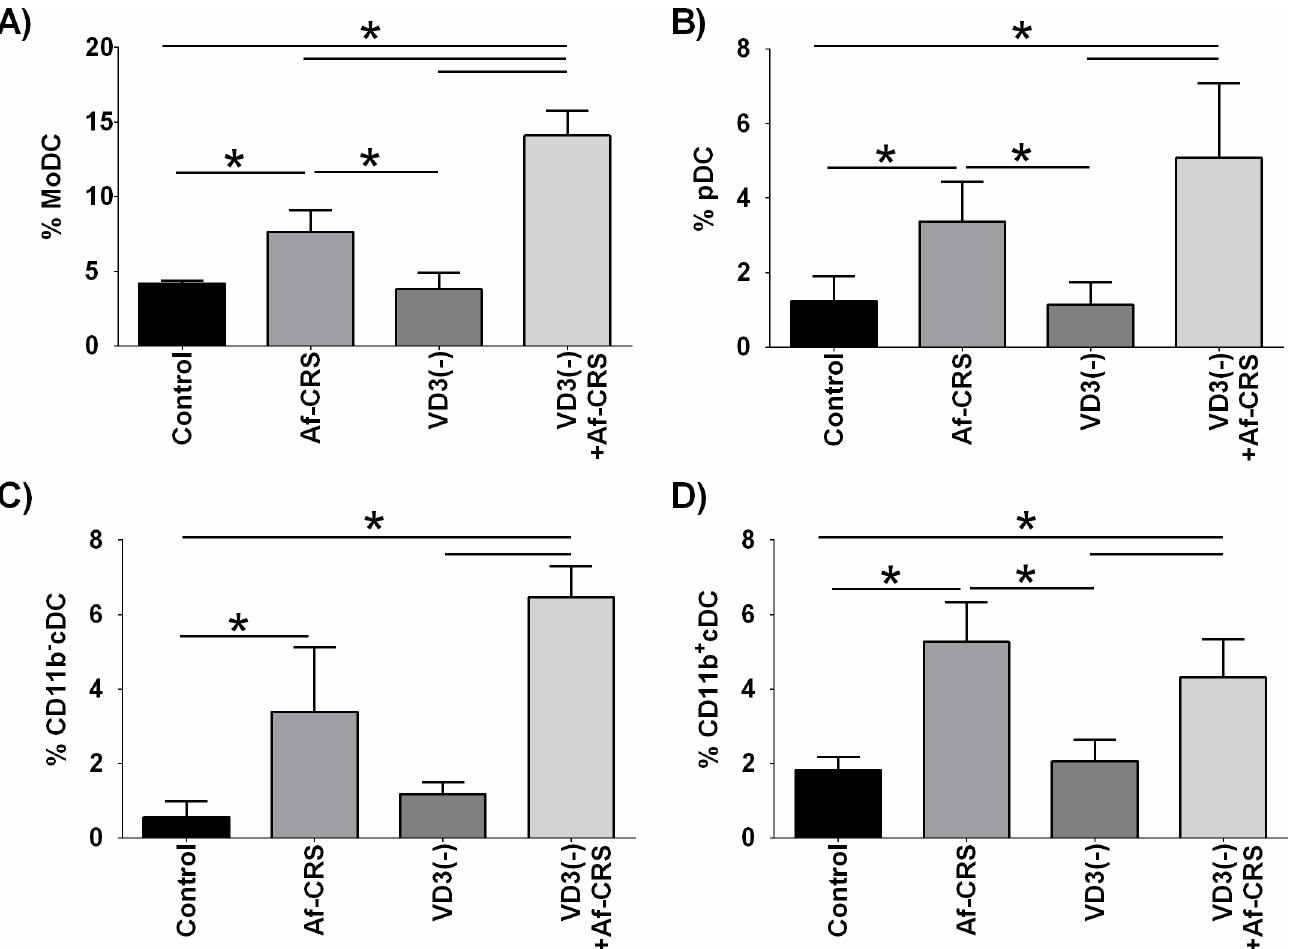
Fig 7. VD3 deficiency exacerbatesincreases in sinonasal moDCs, associatedwith Af-CRS. DC subsets were definedby the followingmarker combinations; moDCs = CD11b+, CD206+,CD209+,pDC = CD11b-, PDCA-1+, Siglec-H+, cDC (CD11b-) = CD11b-, CD11c+, CD103+,cDC (CD11b+) = CD11b+,CD11c+, CD115. Dead cells excludedby 7AAD. n = 4/per group. * p < 0.05betweenindicatedgroups.